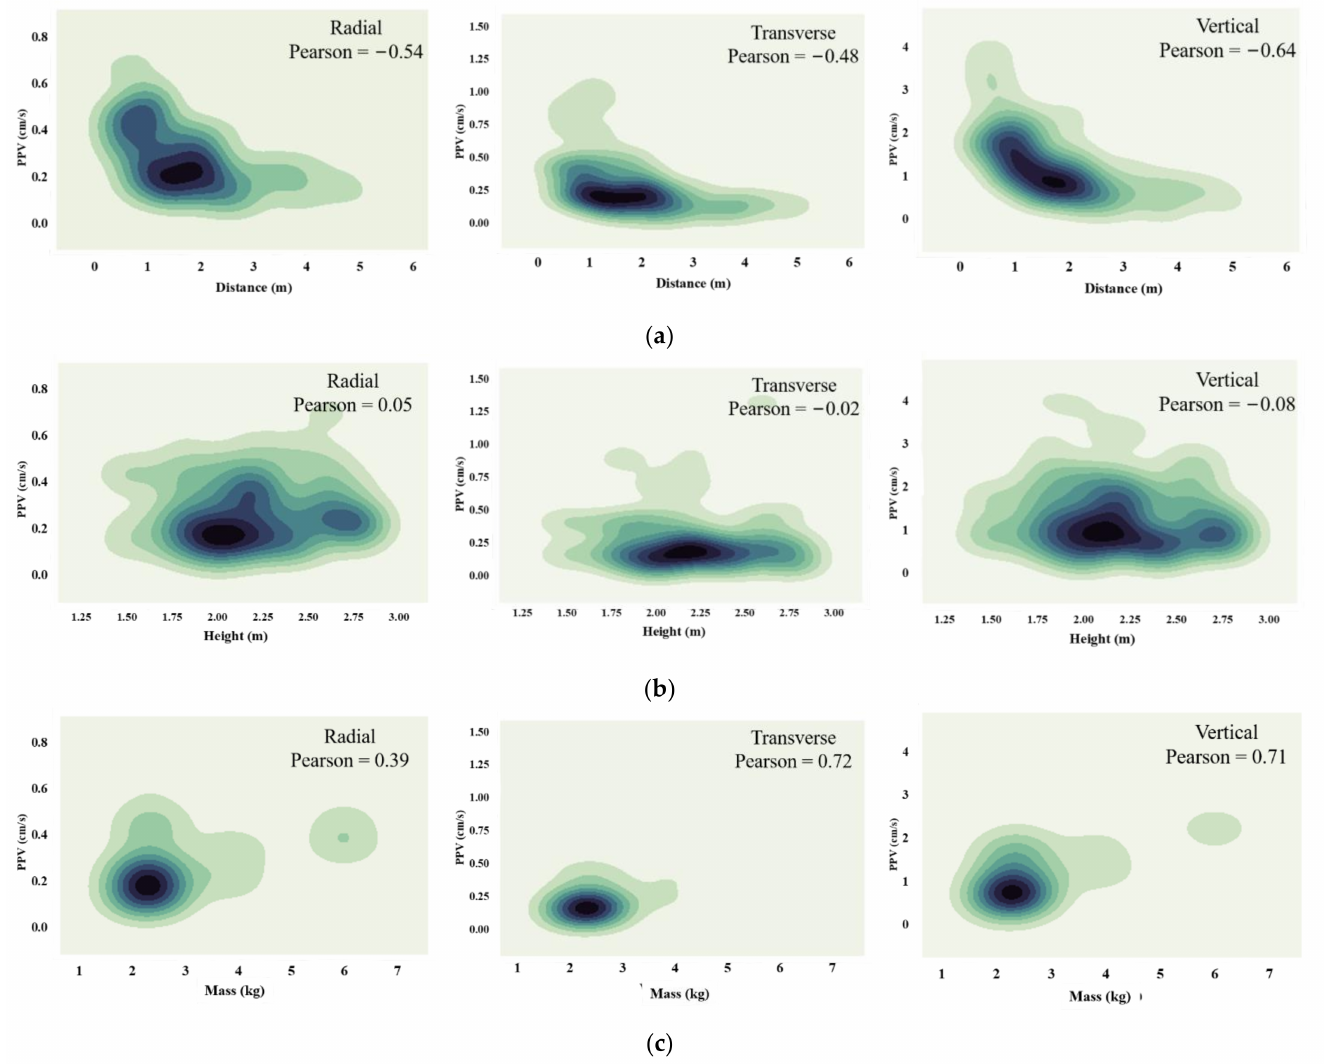
Figure 5. The KDE and Pearson correlation coefficient between the main parameters and PPV: ( a ) Distance; ( b ) Height; ( c )